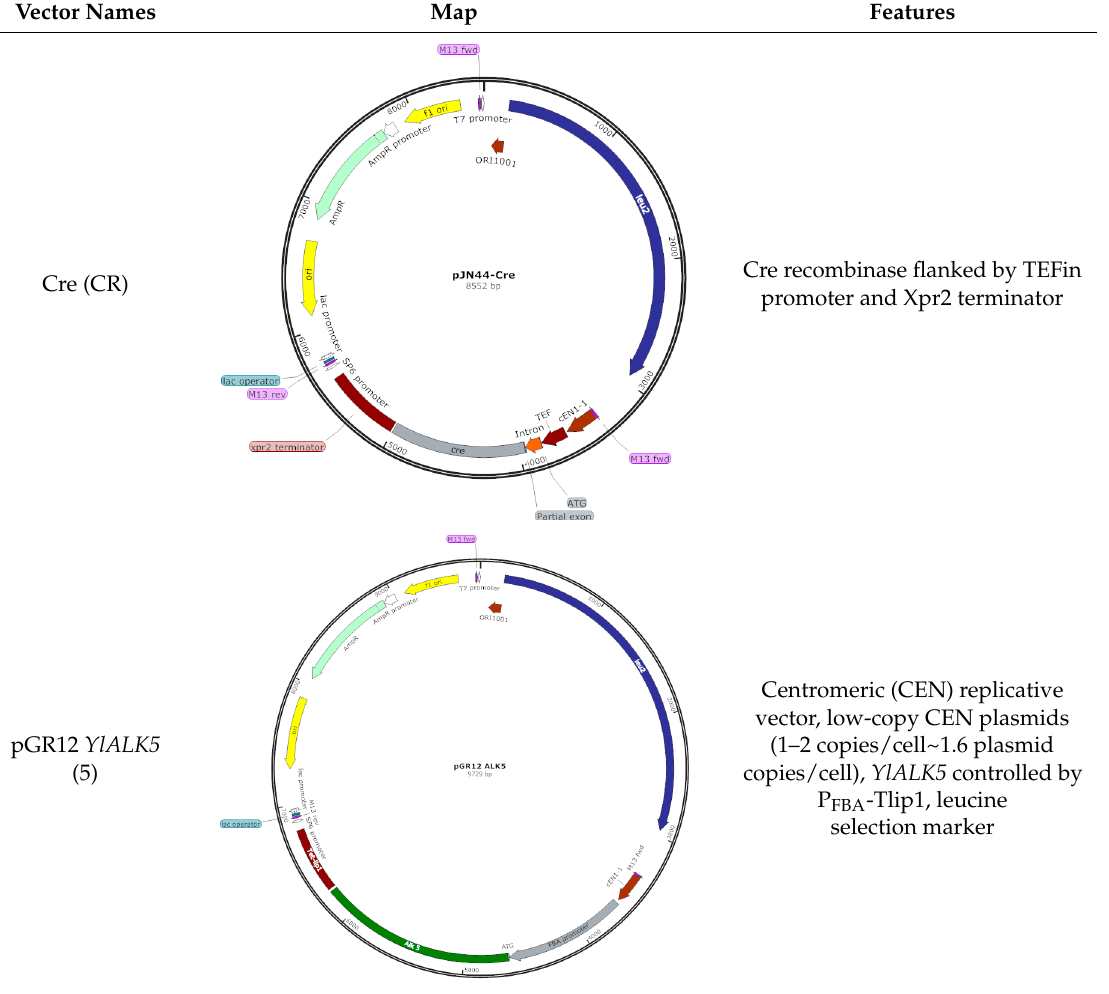
Table 2. Vectors used in this study.